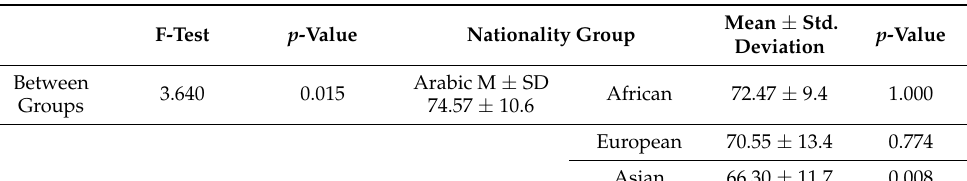
Table 3. Comparisons of the mean score of knowledge between Arabian and other nationality groups, ANOVA: (Scheffe